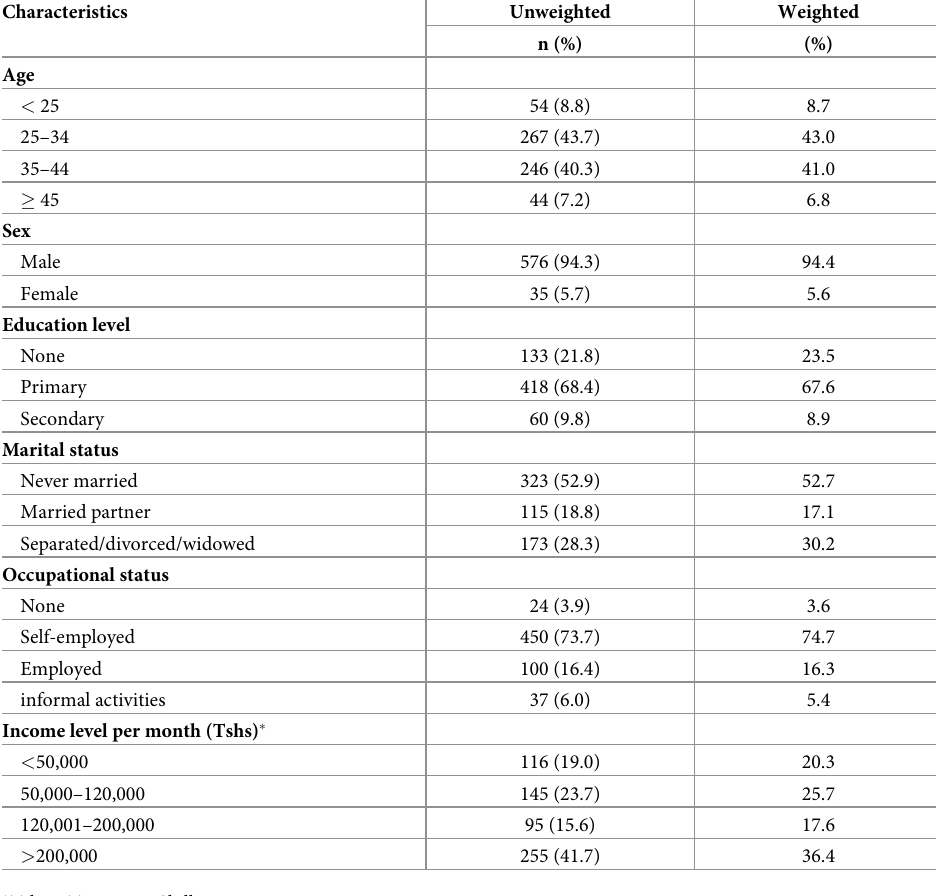
Table 1. Distribution of socio-demographic characteristics of study participants.